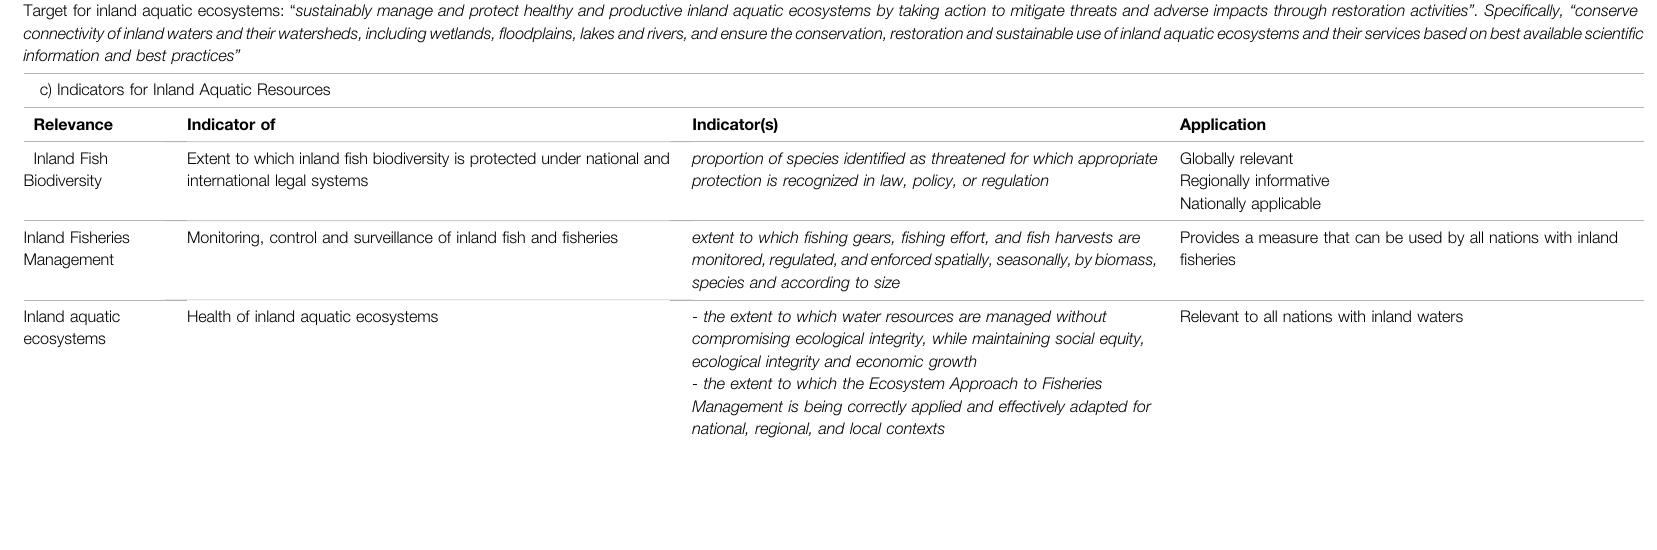
TABLE 1 | ( Continued ) a) Existing SDG Targets and indicators with potential for reporting inland contributions, b) A Framework for supporting implementation and reporting of contributions from inland aquatic ecosystems andtheirservicesshowingatheoreticalsetofobjectivesandc)providinguniversalindicatorsforinland fi sh, fi sheriesandinlandaquaticecosystemsthatcouldbegloballyapplicableandrelevanttonationalcircumstance. The target has much potential for outlining speci fi c inland aquatic 15.1 “ ensure the conservation, restoration and sustainable use of terrestrial -It isalarge andbroadly encompassingtargetandtheconsequence targets locally and freshwater ecosystems and their services. ” of lumping freshwater with terrestrial ecosystems, has meant that their signi fi cance has been largely overlooked due to the greater attention garnered by terrestrial life and forests (Juffe-bignoli et al., 2016) Forests are speci fi cally covered under other SDG15 targets (15.3, Indicator 15.1.1. could recognize fl ooded forest and wetlands Indicator15.1.1: “ Forestareaasaproportionoftotallandarea ” Indicator 15.4) yet are also the focus of this quite general target (15.1) 15.5.2: “ Proportion of important sites for terrestrial and freshwater biodiversity that are covered by protected areas, by ecosystem type ” Under indicator 15.1.2 all inland aquatic could ecosystems could be recognized and reported - Specifying inland aquatic ecosystem targets would help highlight and recognize their contribution so they are not lost in the greater focus of terrestrial habitats and forests b) Objectives for Inland Aquatic Resources Target for inland fi sh: “ conserve and manage vulnerable inland aquatic life, prevent extinctions, and ensure biodiversity conservation including by establishing legal provision for the protection of species Target for inland fi sheries: “ effectively control, illegal and unregulated fi shing and destructive fi shing practices, develop native species aquaculture where possible, ensuring aquaculture does no harm; and implement ecosystem-based management, to maintain fi sh and aquatic biota productivities, at least to levels that can be harvested sustainably, as determined by biological characteristics and the best available data ” Target for inland aquatic ecosystems: “ sustainably manage and protect healthy and productive inland aquatic ecosystems by taking action to mitigate threats and adverse impacts through restoration activities ” . Speci fi cally, “ conserve connectivityofinlandwatersandtheirwatersheds,includingwetlands, fl oodplains,lakesandrivers,andensuretheconservation,restorationandsustainableuseofinlandaquaticecosystemsandtheirservicesbasedonbestavailablescienti fi c information and best practices ”